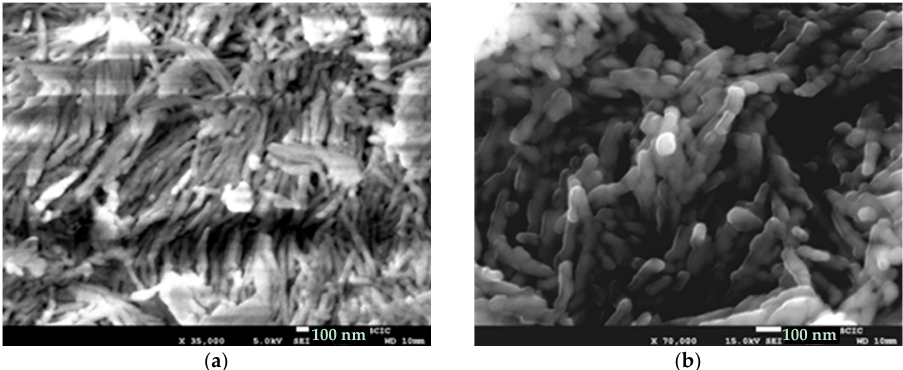
Figure 10. FE-SEM images ( a , b ) and TEM images ( c ) of templated nanofibrous CePO 4 annealed at 600 °C (air conditions); ( d ) FE-SEM image of templated CePO 4 annealed at 900 °C (air conditions).